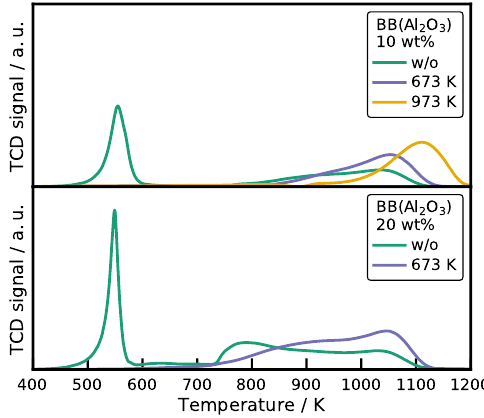
Figure 7. The TPR profiles of the spray-dried Ni/Al 2 O 3 catalysts. Conditions: m cat = 20mg, β = = 30mL N min − 1 10Kmin − 1 , ˙ V H 2 /Ar